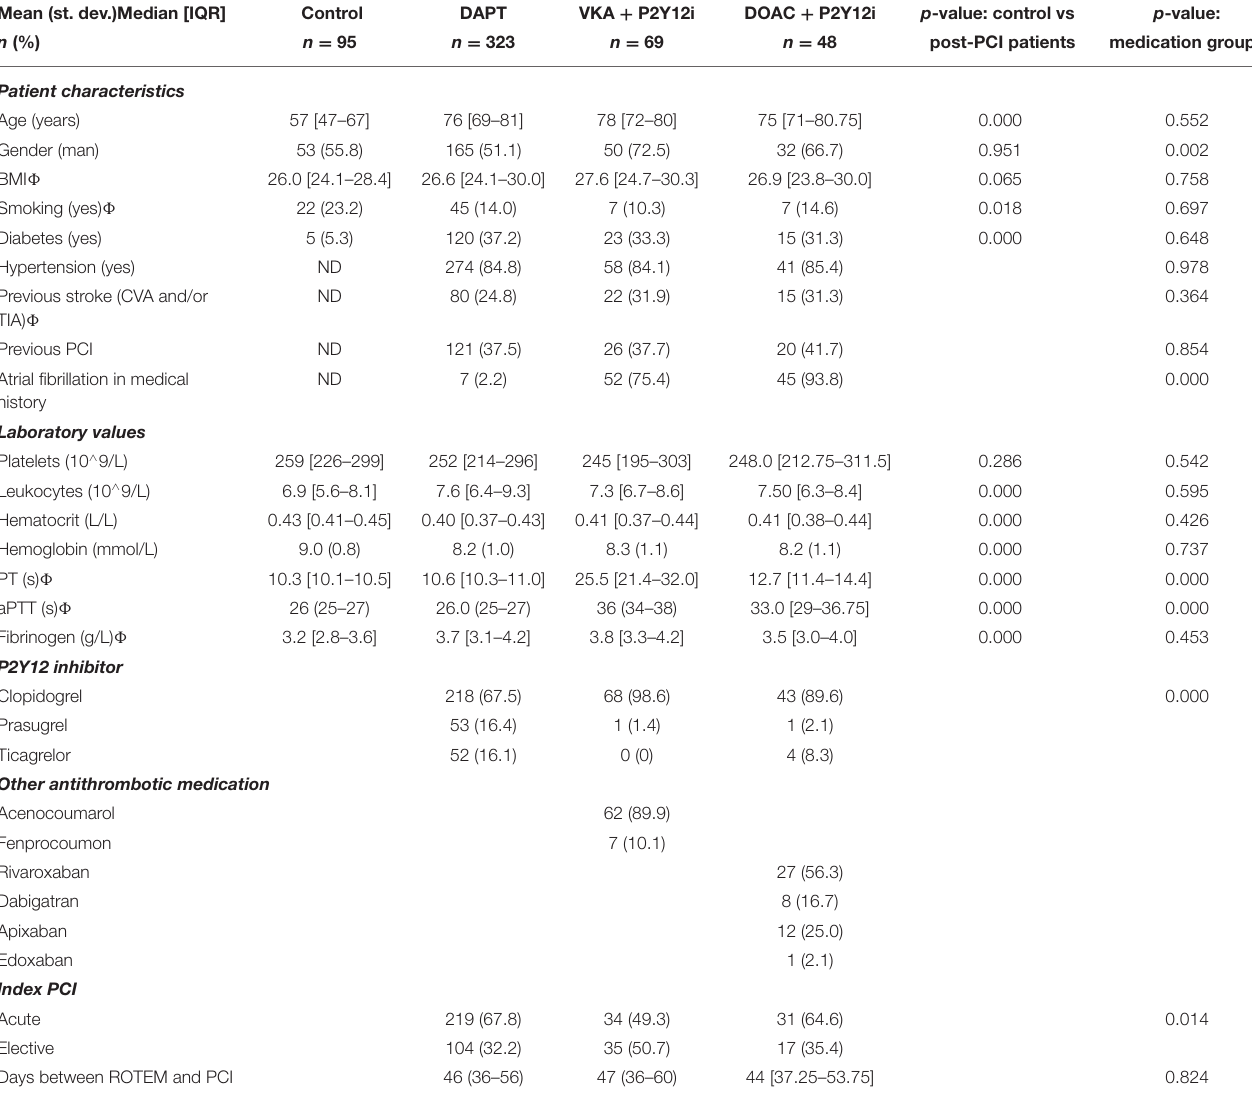
TABLE 1 | Demographics, baseline characteristics and routine laboratory values of the control, DAPT, VKA + P2Y12i and DOAC + P2Y12i groups. Mean (st. dev.)Median